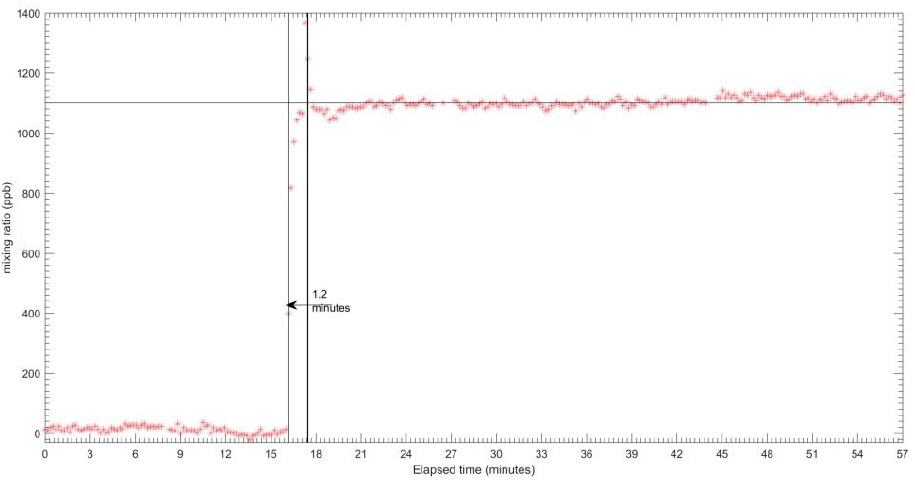
Figure 5. Response times of CO-A4 EC sensor from zero target gas to target gas.